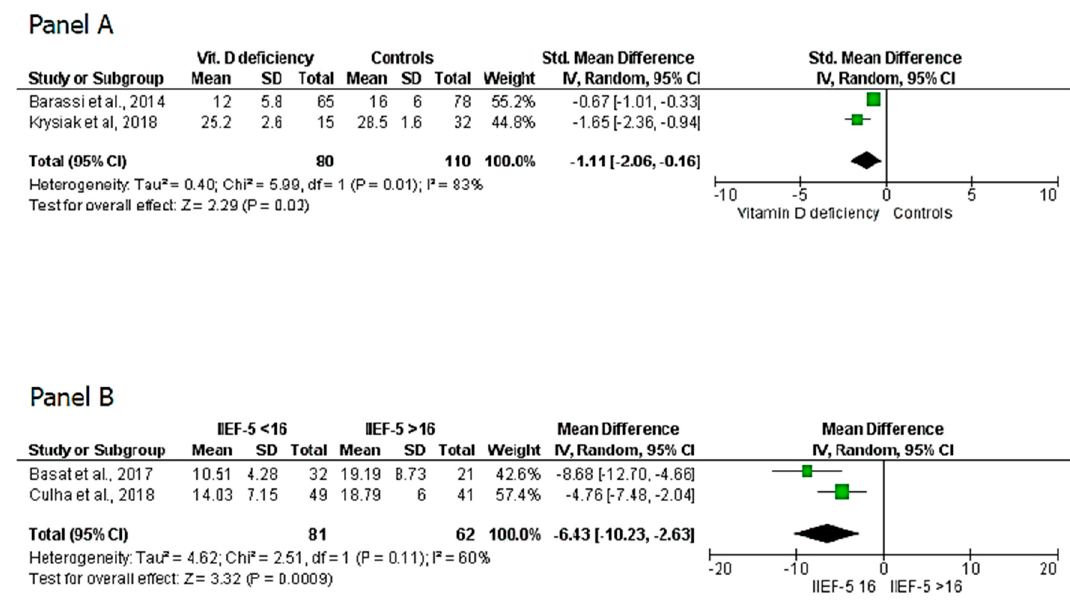
Figure 3. ( Panel A ) International index of erectile function-5 (IIEF-5) scores in patients with 25-hydroxy-Vitamin D < 20 ng / mL vs. patients with 25-hydroxy-Vitamin D ≥ 20 ng / mL. ( Panel B ) 25-hydroxy-Vitamin D levels in patients with IIEF-5 score < 17 vs. patients with 17 < IIEF-5 score ≤ 25.